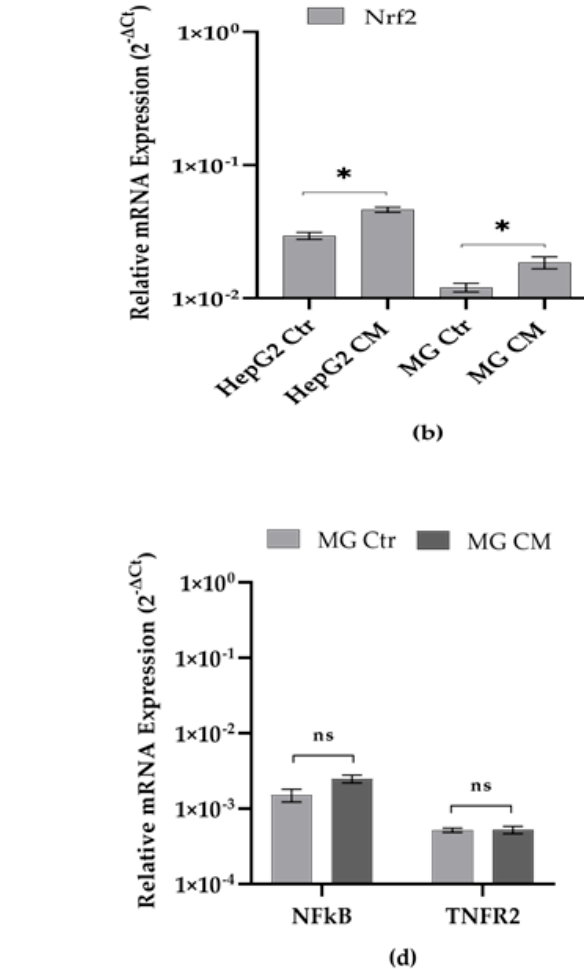
Figure 5. Effect of conditioned media on expression levels of iNOS, Nrf2, NFkB, and TNFR2. Transcript levels of ( a ) iNOS, (b ) Nrf2, ( c , d ) NFkb and TNFR2 were evaluated in HepG2 and HMC-III cells grown for 48 h in conditioned (HepG2 CM and MG CM, respectively) and own-culture medium (HepG2 Ctr and MG Ctr, respectively). Results are expressed as 2 −Δ Ct and presented as the mean ± SEM of at least three different experiments. Statistical analysis was performed by using t -test; * p < 0.05, ** p < 0.01; control (Ctr) cells vs. media-conditioned (CM) cells; ns: not significant p value.